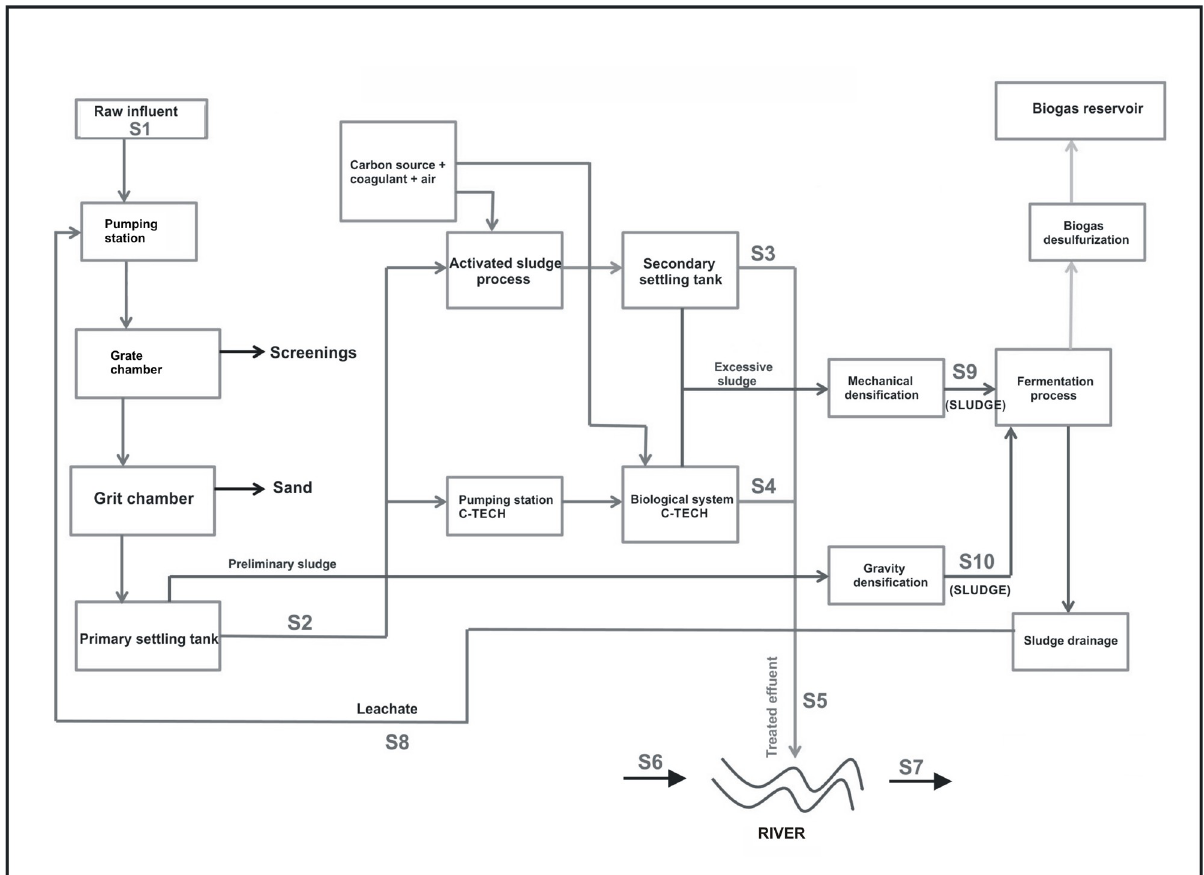
Fig 1. Scheme of municipal wastewater treatment plant with the samples localization. S1—Untreated wastewater; S2—Wastewater after the primary settling tank; S3—Wastewater after the secondary settling tank; S4—Wastewater after the selector and C-TECH reactor; S5—Treated wastewater; S6 – River water before the discharge of treated wastewater; S7 –River water after the discharge of treated wastewater; S8—leachates; S9—Sludge after the mechanical compression; S10—Sludge after the gravity compression.